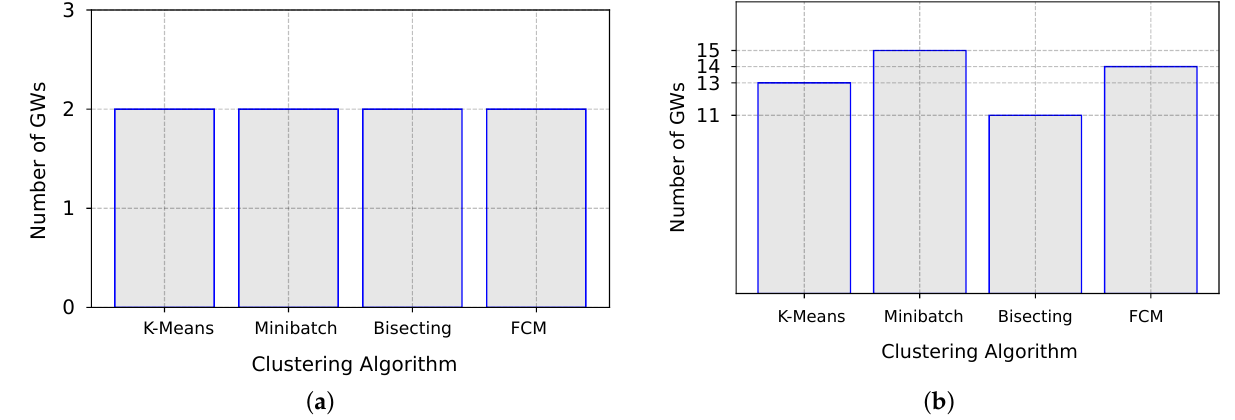
Figure 7. Number of GWs obtained by each clustering algorithm for ( a ) Scenario 1, and ( b ) Scenario 2. Different cluster models are available in the literature, and distinct algorithms can be provided for each of these cluster models. Clusters discovered by one clustering method will probably differ from clusters discovered by another technique; this explains why the ULDR differed from one algorithm to another in Scenario 2, in which more random factors took place (Figure 8). The performance of the clustering algorithms, regarding the ULDR for Scenario 1, showed no considerable difference among the clustering techniques, according to the graph shown in Figure 8a; the FCM algorithm gave the best performance, by a small margin; on the other hand, considering Scenario 2, Figure 8b shows that the K-Means algorithm performed better for all the suggested GW quantities.